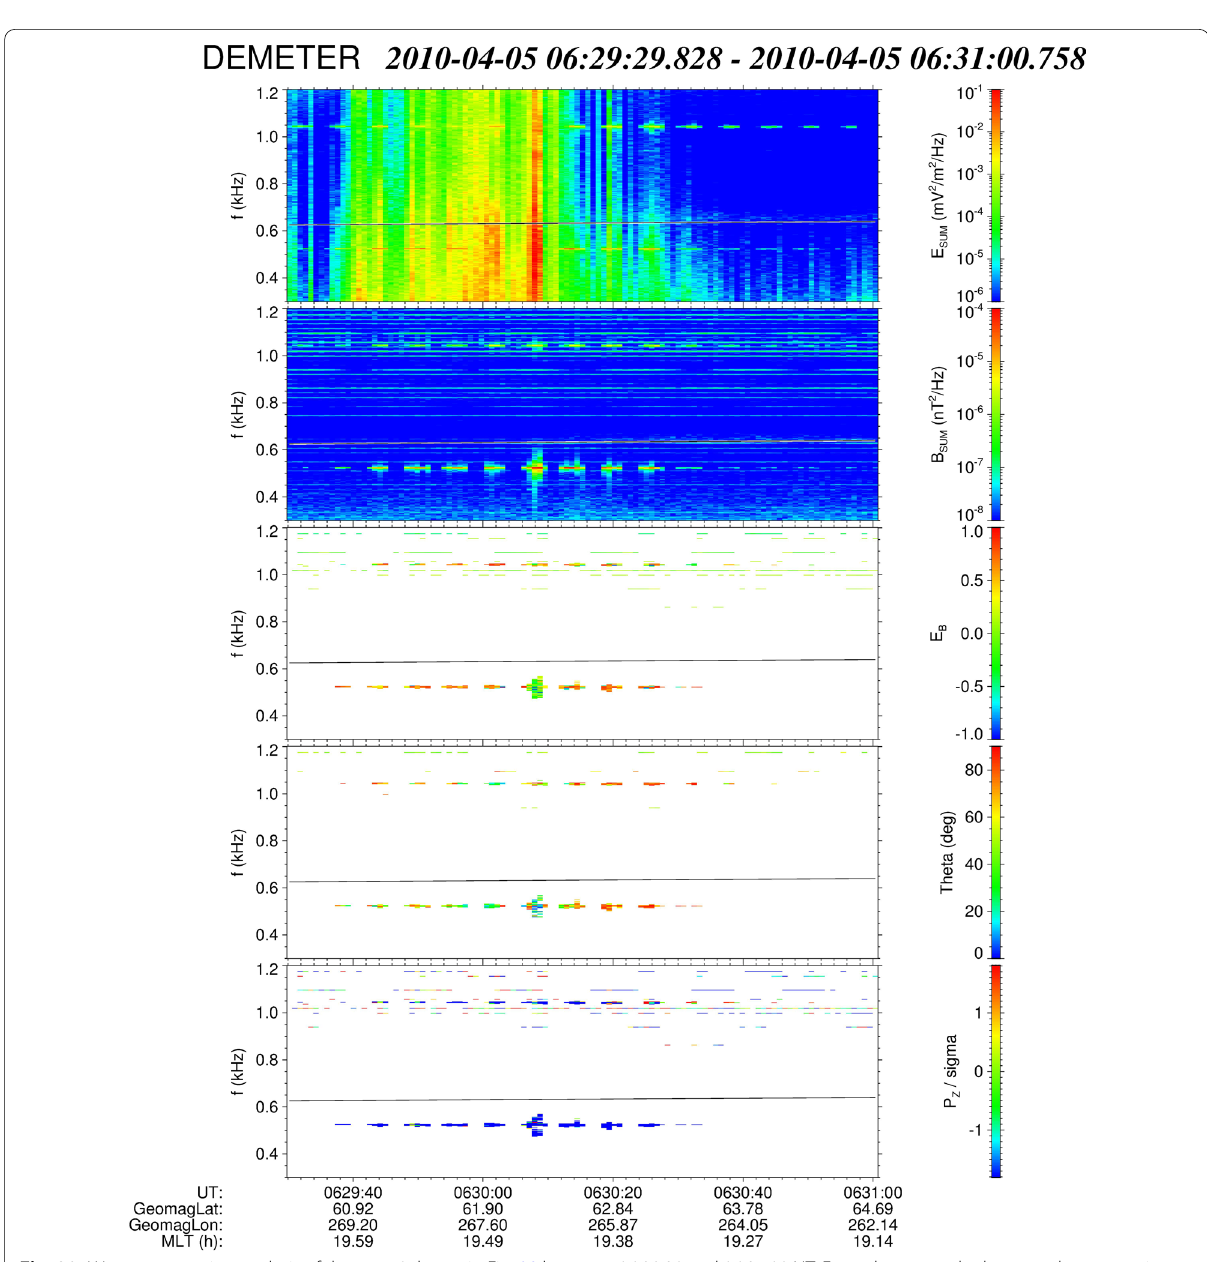
Fig. 29 Wave propagation analysis of the case 6 shown in Fig. 28 between 06:29:30 and 06:31:00 UT. From the top to the bottom: the magnetic field spectrogram, the electric field spectrogram, the ellipticity of magnetic field, the polar angle θ , and the Poynting vector component along the terrestrial magnetic field normalized by the standard deviation (see text for explanation). All parameters are color-coded according to the scales on the right. The frequency range is from 300 Hz up to 1.2 kHz. In each panel the line just above 600 Hz represents the proton gyrofrequency. The parameters displayed on the abscissa are the time in UT, the geomagnetic latitude and longitude, and the magnetic local